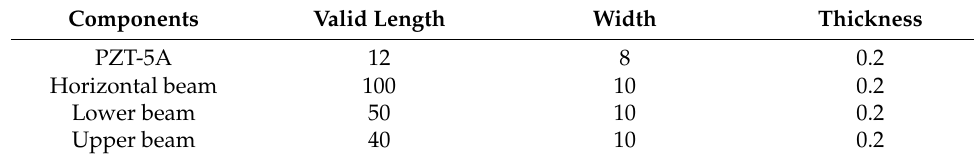
Table 1. The dimensions of components in U-shaped structure (Unit: mm).